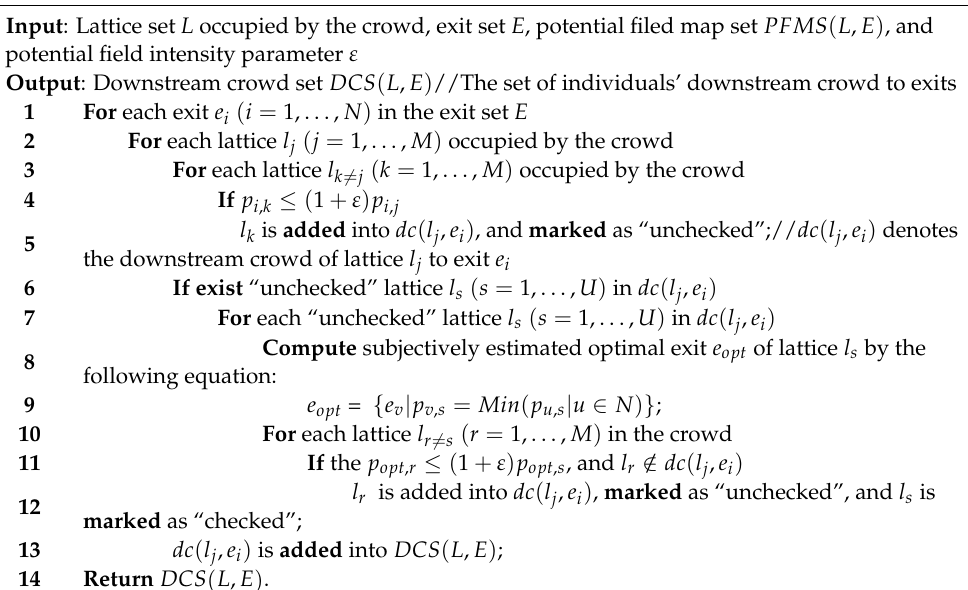
Algorithm 2: Individual’s downstream crowd identification based on potential field